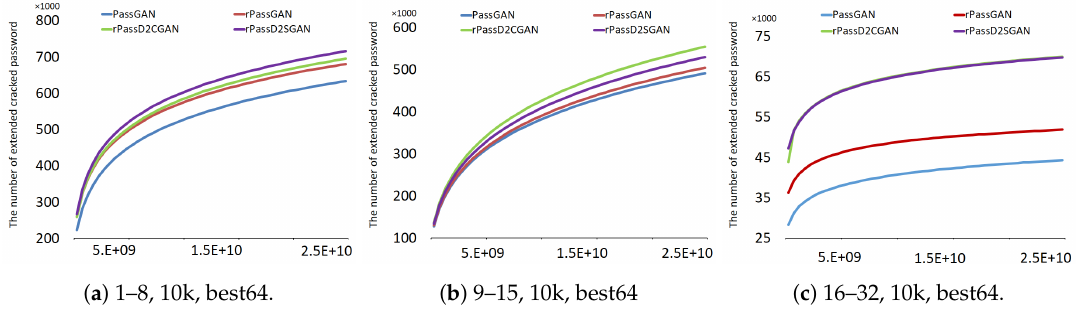
Figure 9. Total cumulative cracked passwords by the number of guessed passwords.